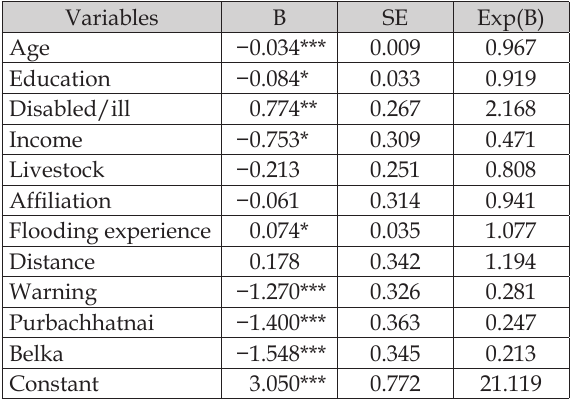
Table 5. Logistic regression results for factors asso - ciated with evacuation behaviour (1 = evacuated; 0 = not evacuated, n = 377, year